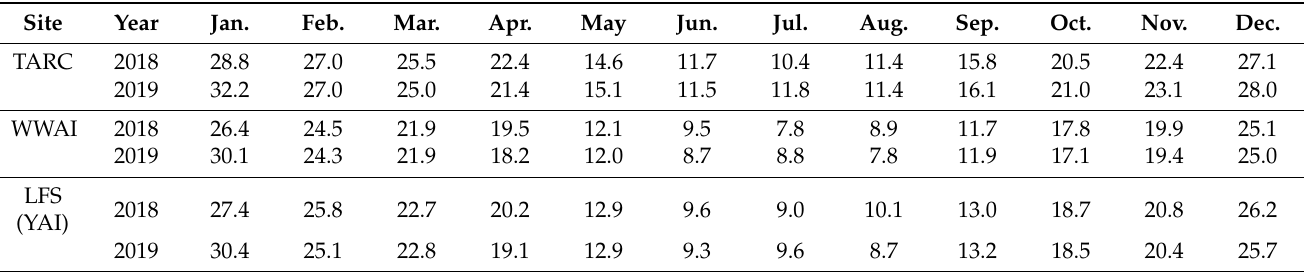
Table 3. Mean temperature at the experimental sites during the years in which the experiments were conducted. For site abbreviations, see